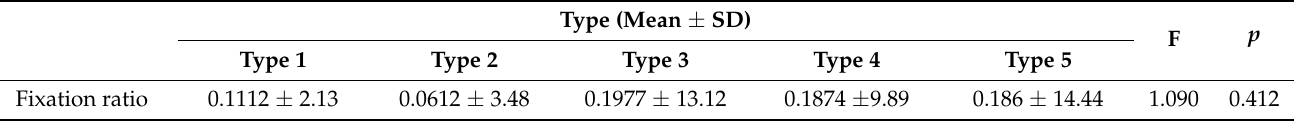
Table 31. Analysis of variance for the proportion of key fixation points of different